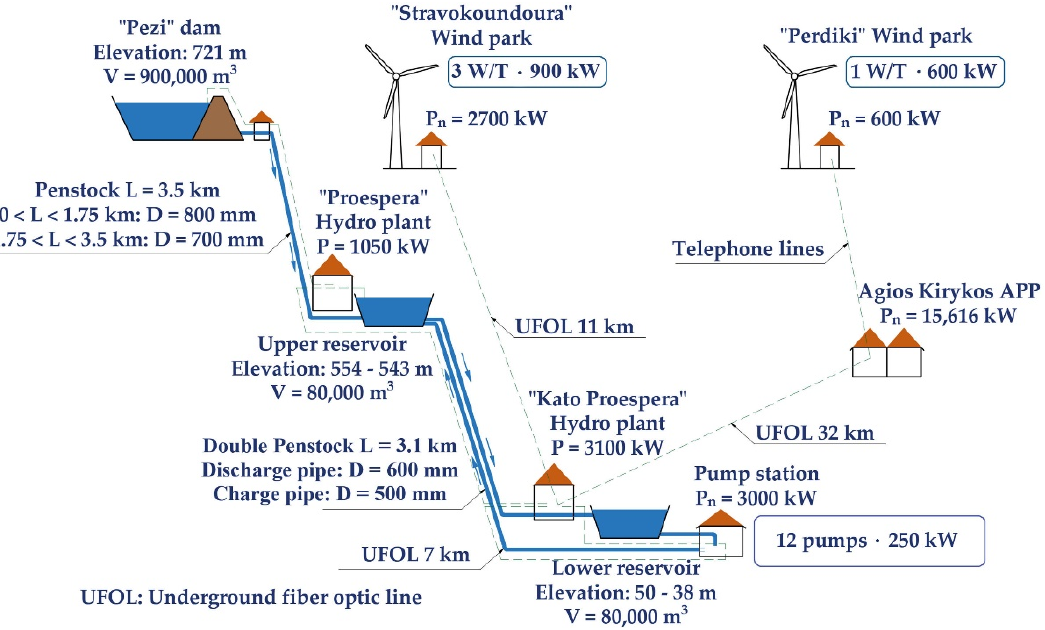
Figure 10. The layout of the hybrid power plant in Ikaria [91].